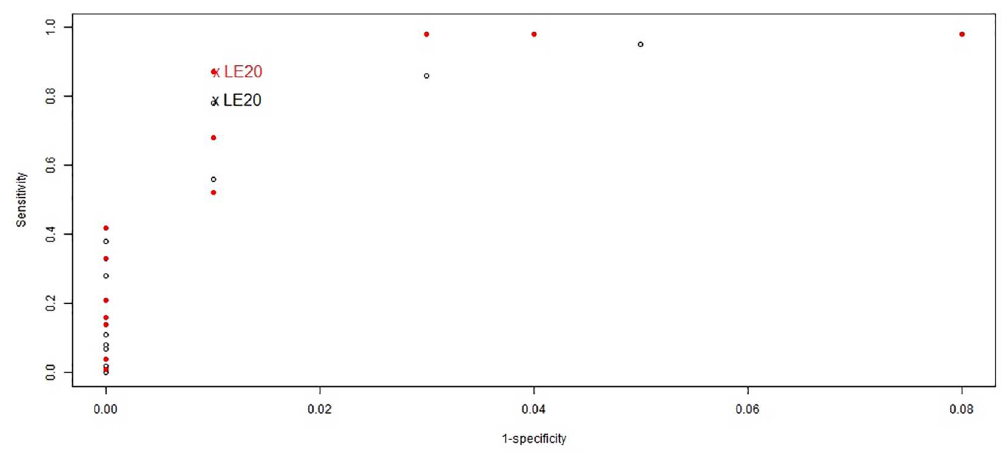
Fig 2. Performance of localized epidemic definitions in detecting elevated annual meningitis incidences at the health area level; in Tahoua, Tillabery and Dosso regions, Niger, 2002–2012 (3,357 health area years). Empty marks represent the performance in detecting annualincidences (cid:21) 130 cases per 100,000 which corresponds to the 95 th percentileof all annualincidences in the database.Full and red marks represent the performance in detecting annualincidences (cid:21) 210 cases per 100,000 inhabitants which correspondsto the 97.5 th percentileof all annualincidencesin the database. Definitions for localizedepidemicsare based on different thresholdsof weekly incidencerates per 100,000 inhabitants(5, 10, 15, 20, 30, 40, 50, 60, 70, 80, 90, 100, 150, 200 suspected cases) with incidencesmaintainedduring at least two weeks. LE20 indicatesthe threshold retained for further